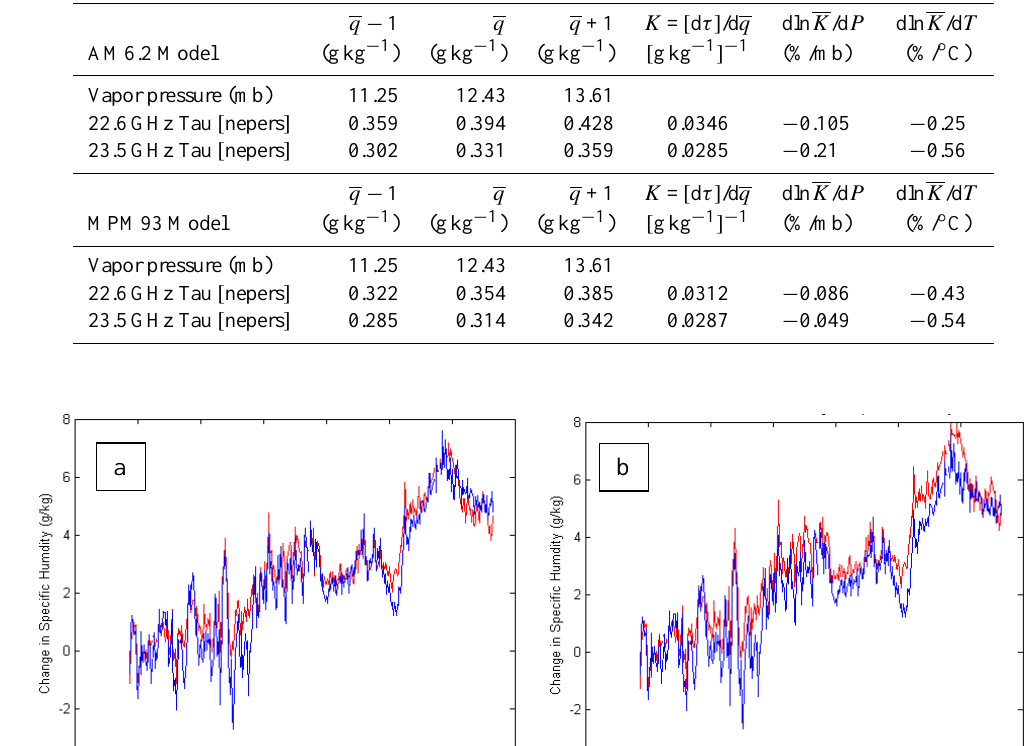
Table 1. Conversions between changes in optical depth and the average specific humidity, q , along a 5.4km path.